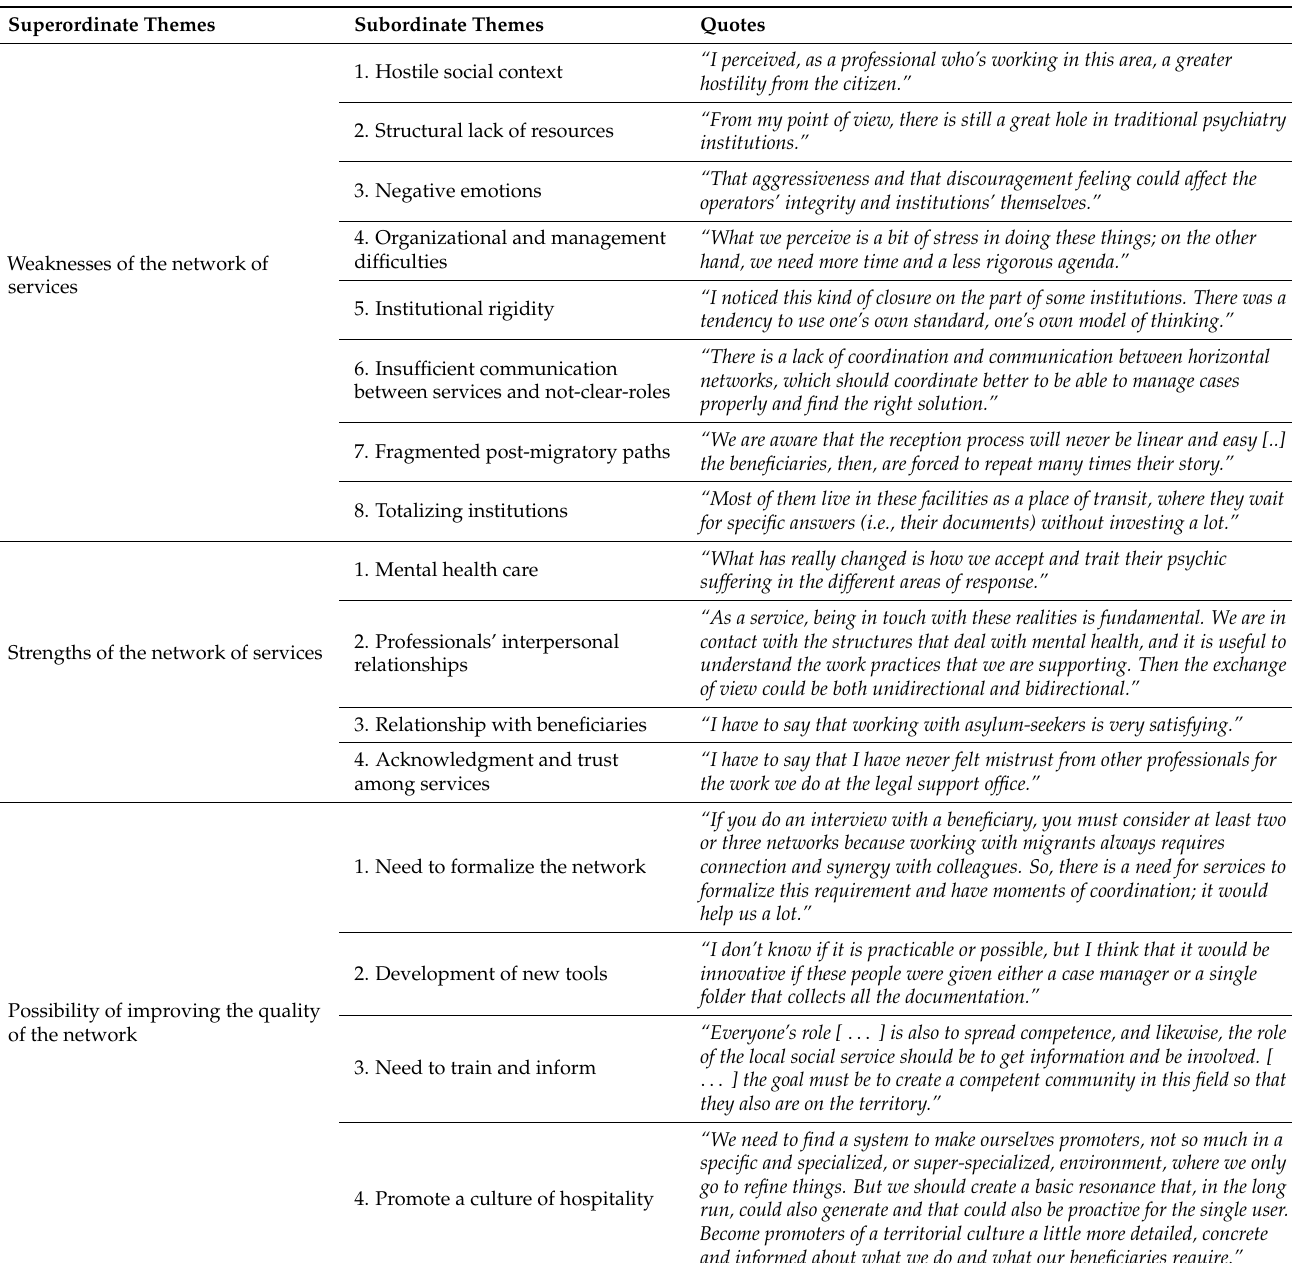
Table 3. Superordinate and subordinate